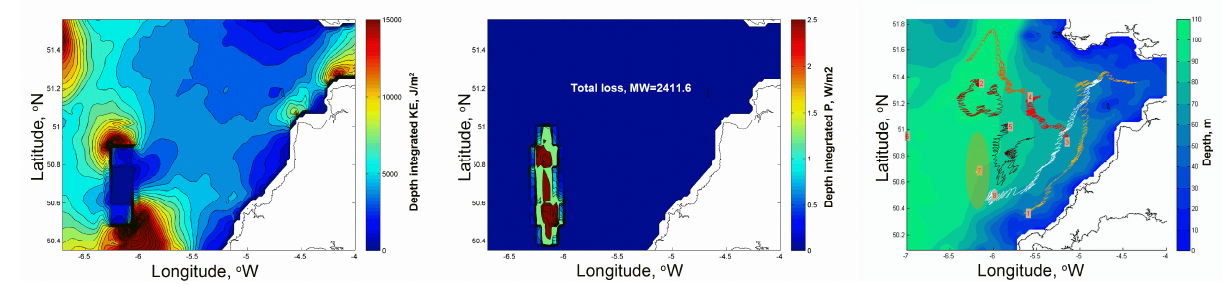
Fig. 8. Effect of the farm shape on the main parameters of the flow. Left panel- kinetic energy per unit area (Jm − 2 ) ; middle panel- mean extracted power in Wm − 2 ; right panel – simulated trajectories of Lagrangean drifters drogued at 22.5m depth, for a farm extended along the meridian. The rated capacity of the farm (i.e. the number of turbines) is the same as for high-rated circular farm shown in Figs. 5–7. The shape of the farm is shown by a shaded oval on the right panel.